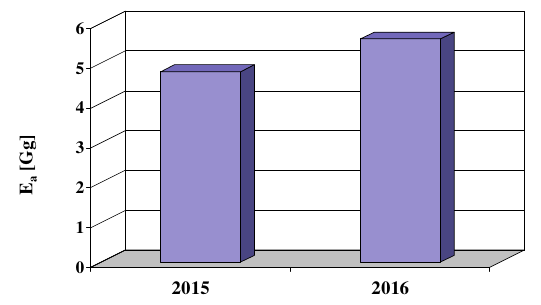
Fig. 14. National annual emission of ammonia from motor vehicles in 2015 and